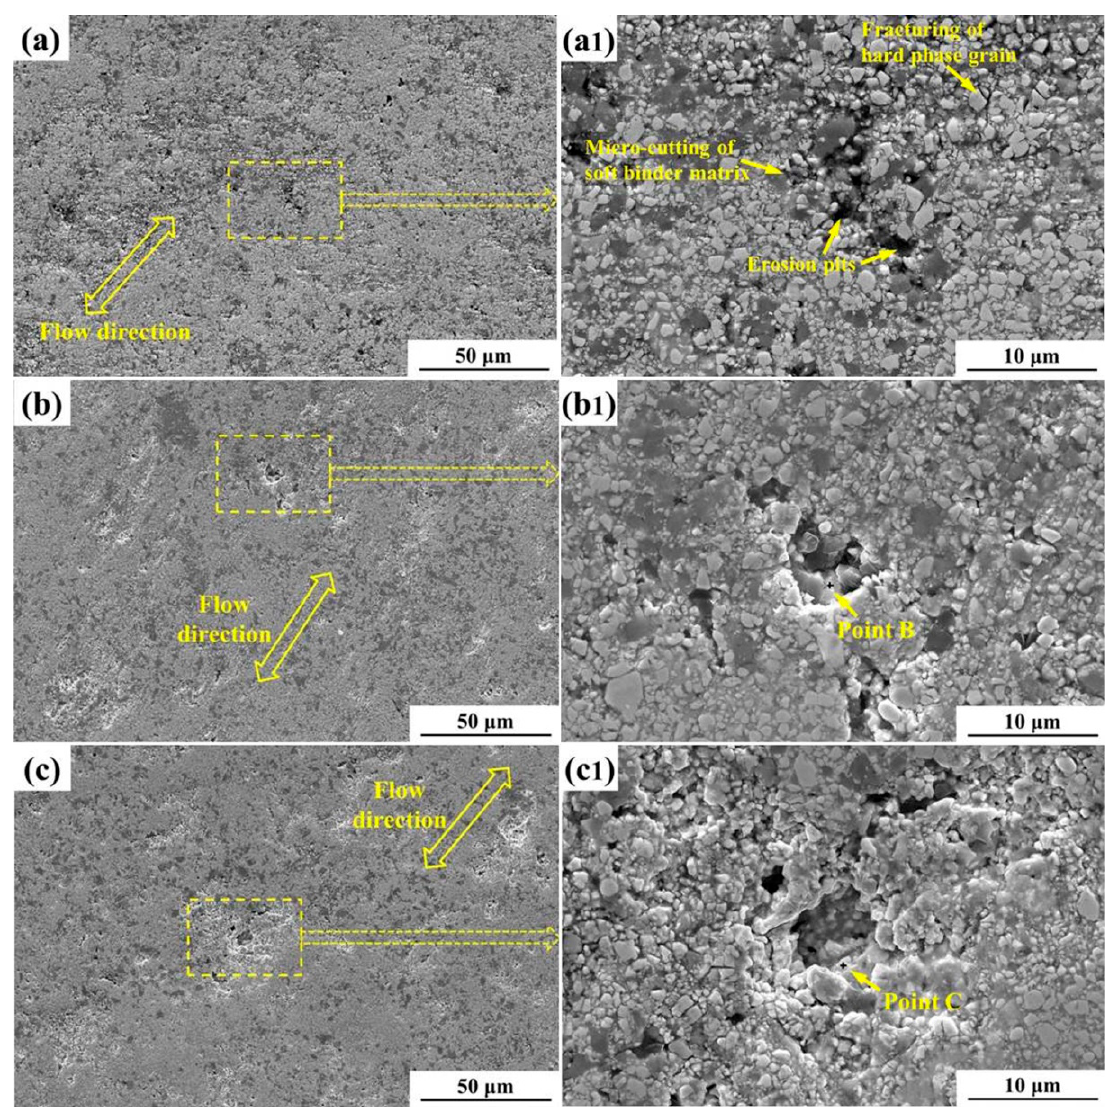
Figure 6. FE-SEM images of the WC-Cr 3 C 2 -Ni coatings after HAE for 6 h in 3.5 wt.% NaCl aqueous solution at 33.5 m·s − 1 and different SCs: ( a ) 10 kg·m − 3 ; ( a1 ) a magnification of the rectangular frame in ( a ); ( b ) 20 kg·m − 3 ; ( b1 ) a magnification of the rectangular frame in ( b ); ( c ) 35 kg·m − 3 ; ( c1 ) a magnification of the rectangular frame in ( c ). Table 3. Composition of elements in different regions of WC-Cr 3 C 2 -Ni coating after HAE for 6 h in 3.5 wt.% NaCl aqueous solution under different FVs and SCs.